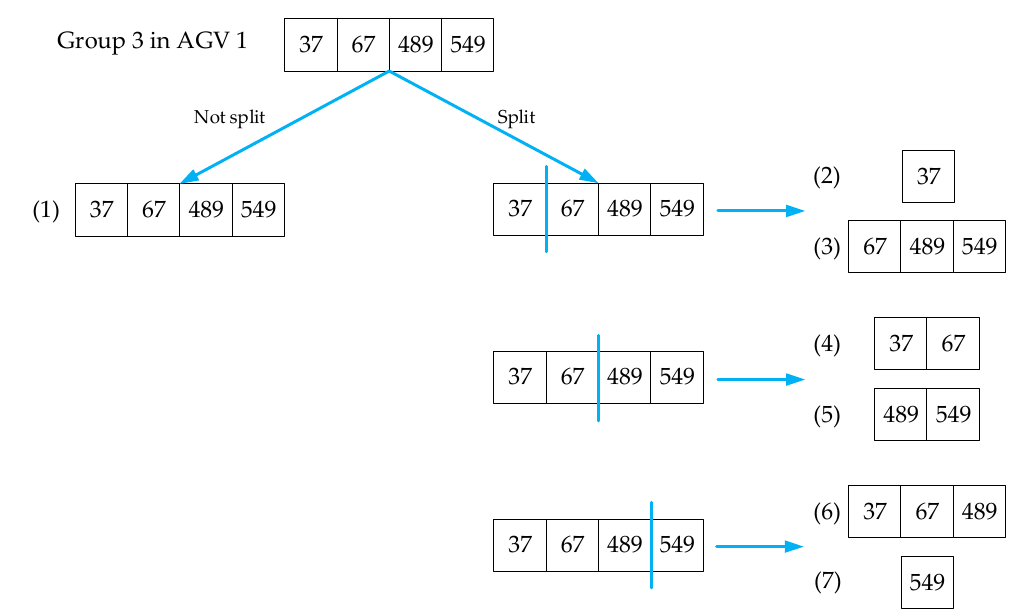
Figure 7. Optional relocation sequences including (1)–(7) in group 3 in AGV 1.